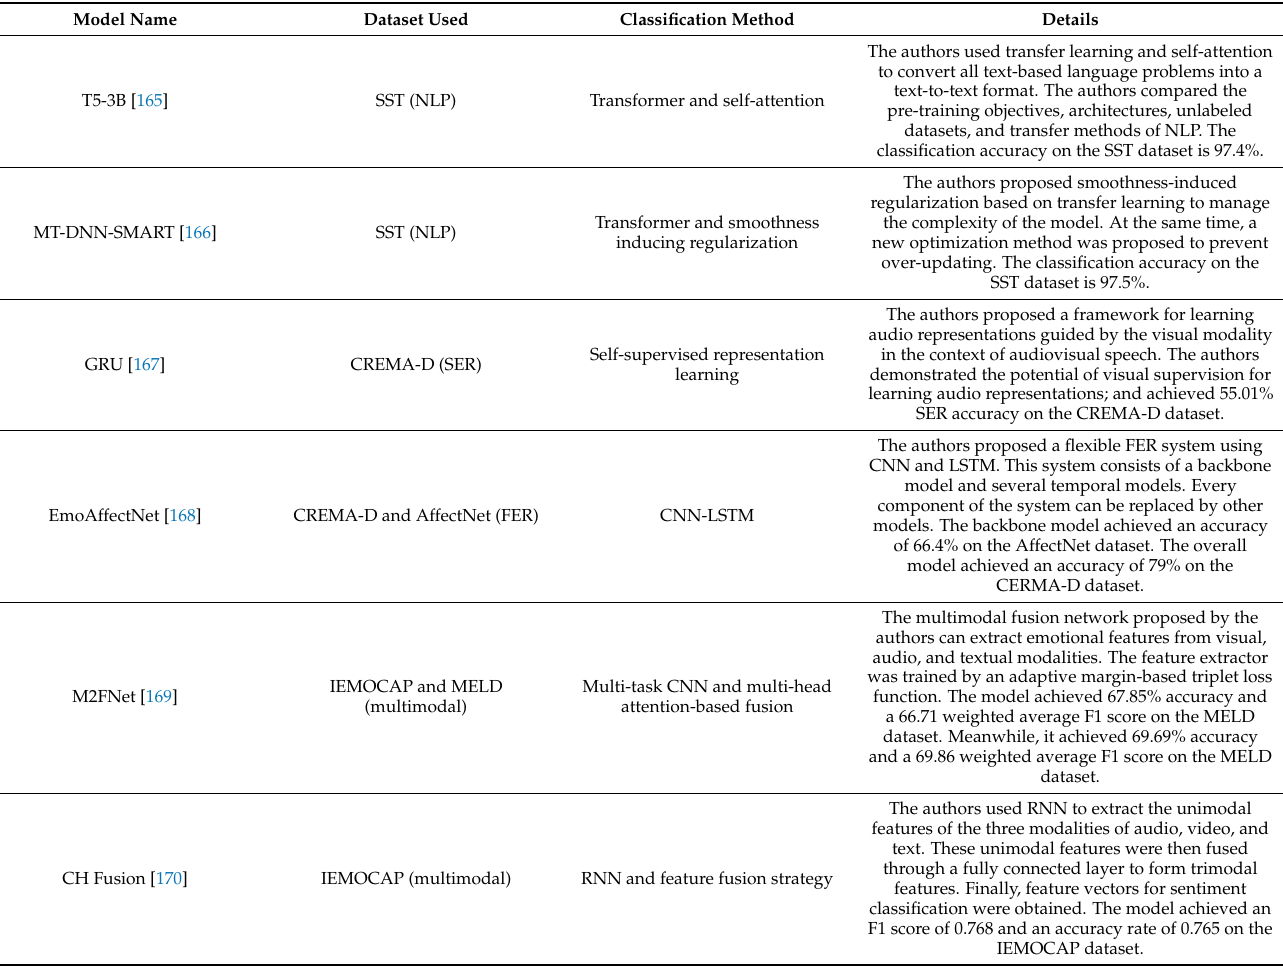
Table 2. Other classification